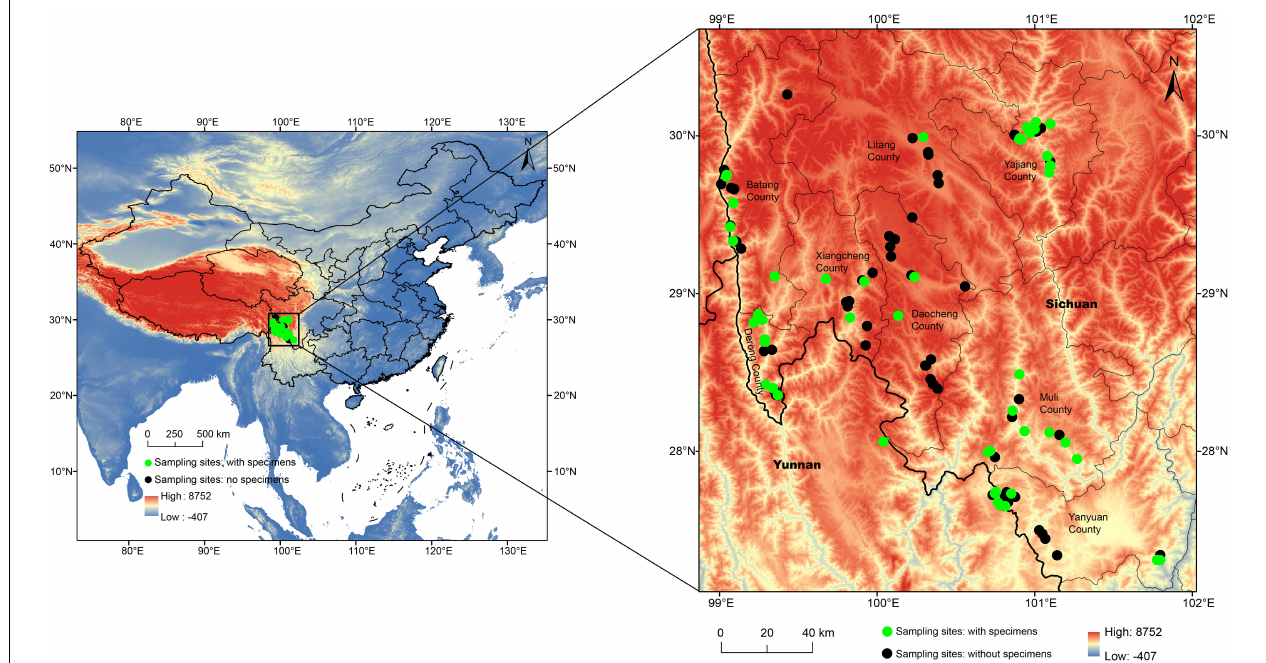
FIGURE 1 | The locations of the 113 sampling sites in the Shaluli Mountains. A green circle represents the site with green lacewings collected, while a black circle represents the site without green lacewings collected.